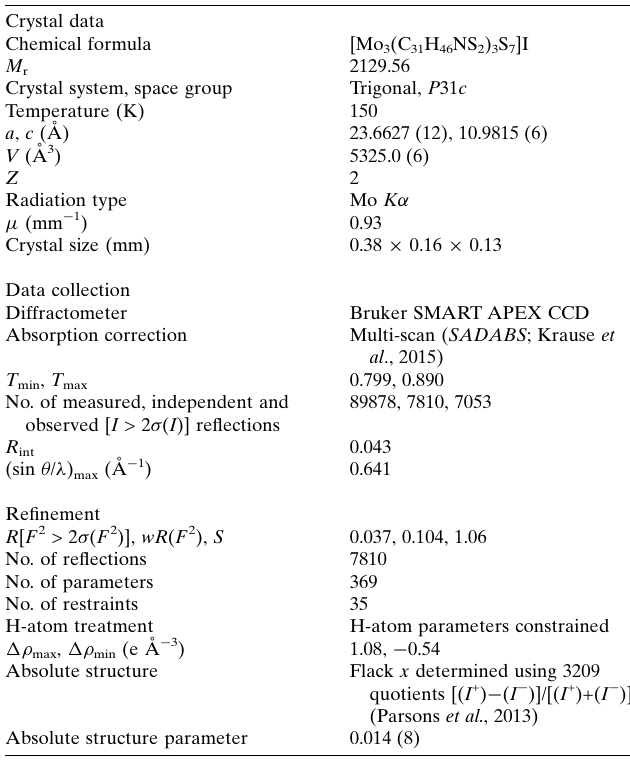
Crystal data Chemical